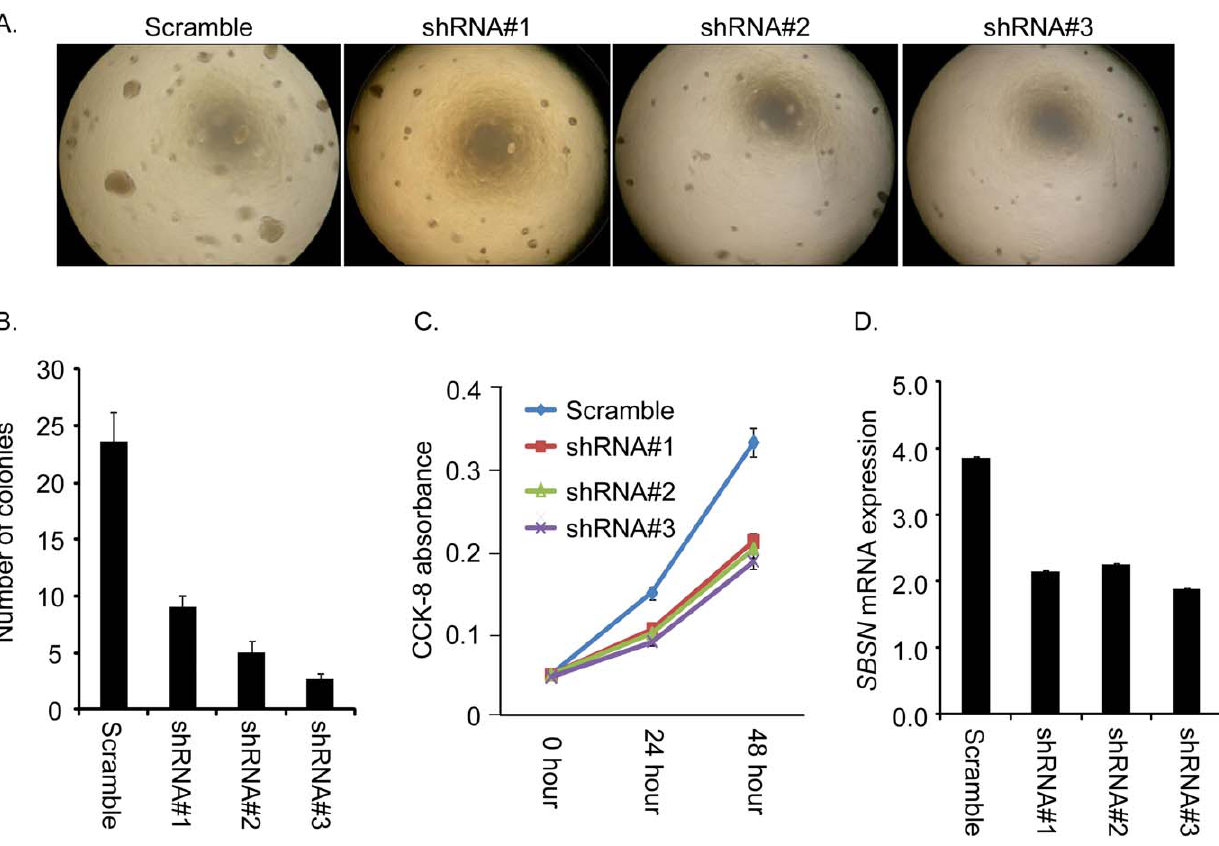
Figure 2. SBSN is important in maintaining anchorage-independent and anchorage-dependent growth in SACC83. Scramble, shRNA 1, shRNA 2, and shRNA 3 indicate the control and three types of SBSN shRNAs used to establish stable clones in SACC83. A, Representative photographs of anchorage-independent growth by soft agar assay. The size of colonies indicates the focus formation ability of each type of stable clone. B, The number of colonies counted in each type of stable clone. C, Anchorage-dependent cell proliferation assay. CCK-8 absorbance indicates the amount of cells at time-points 0, 24, and 48 hours. Scramble clones grew faster than SBSN shRNA stable clones at 24 and 48 hours, p , 0.01. Statistical comparisons were performed with Student’s t-test. Error bars indicate the standard deviation of triplicate assays. D. SBSN mRNA levels in different stable clones were determined by qRT-PCR. This confirmed that SBSN was silenced by , 50% in shRNAs clones compared to scramble clones.